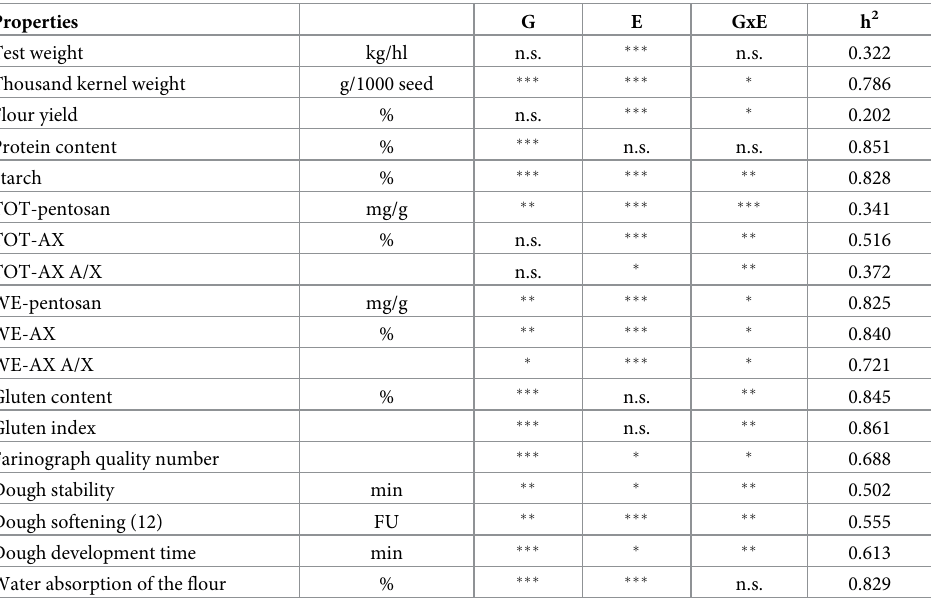
Table 1. Effect of the genotype (G), environment (E.), and their interaction (GxE) on the physical, compositional and breadmaking quality traits of 31 breeding lines using linear mixed model analysis and the heritability values (h 2 ) of the individual